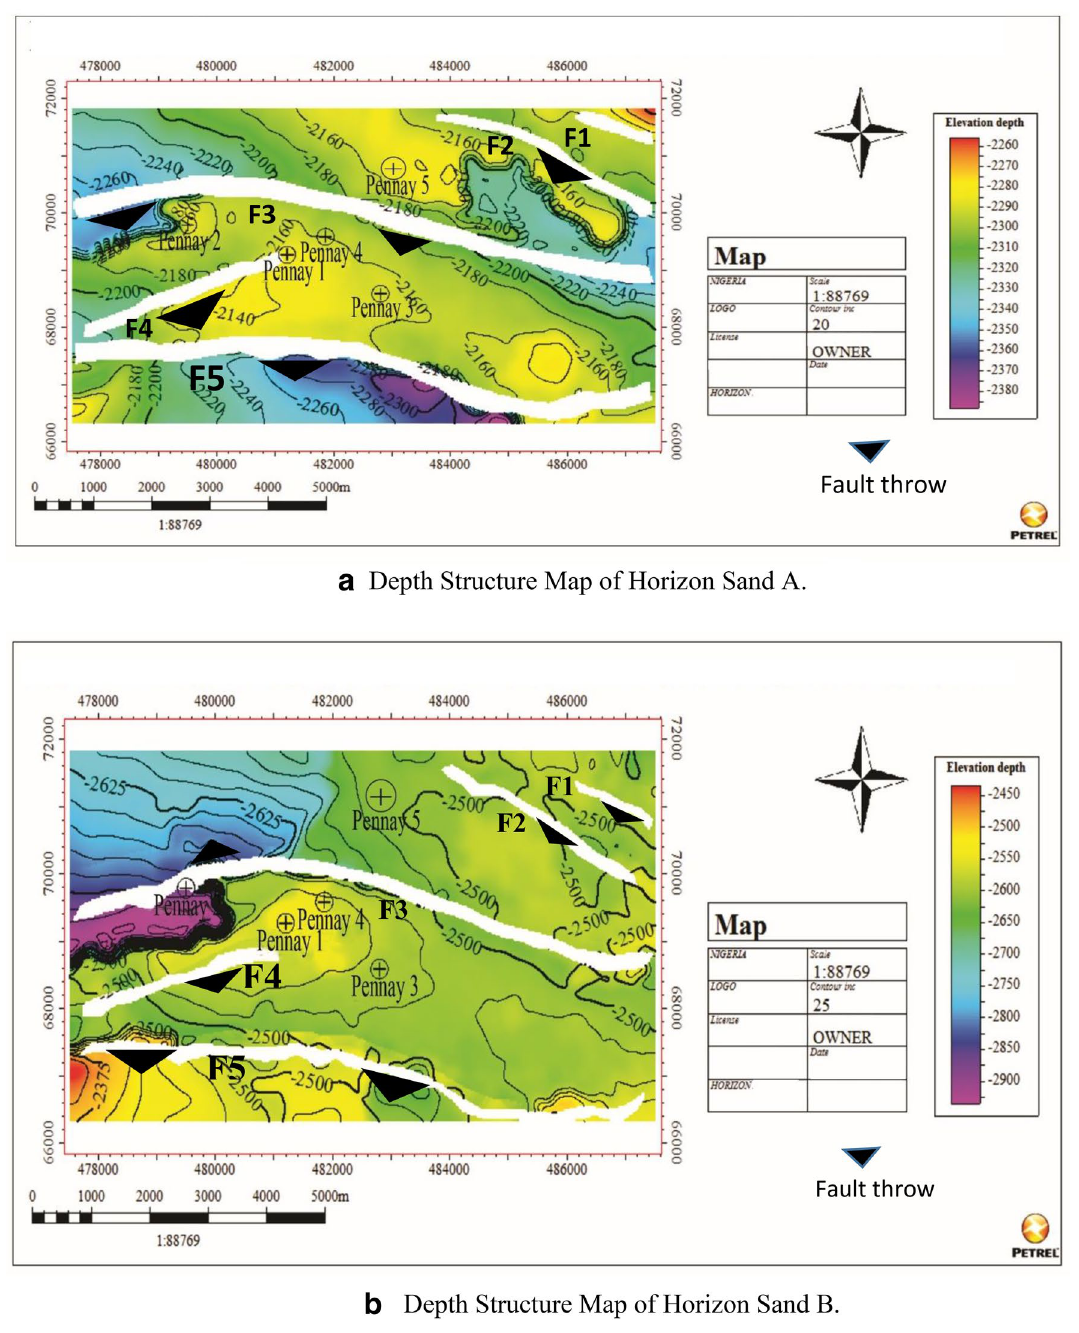
Fig. 8 a Depth structure map of horizon sand A. b Depth structure map of horizon sand B. c Depth structure map of horizon sand C. d Depth structure map of horizon sand